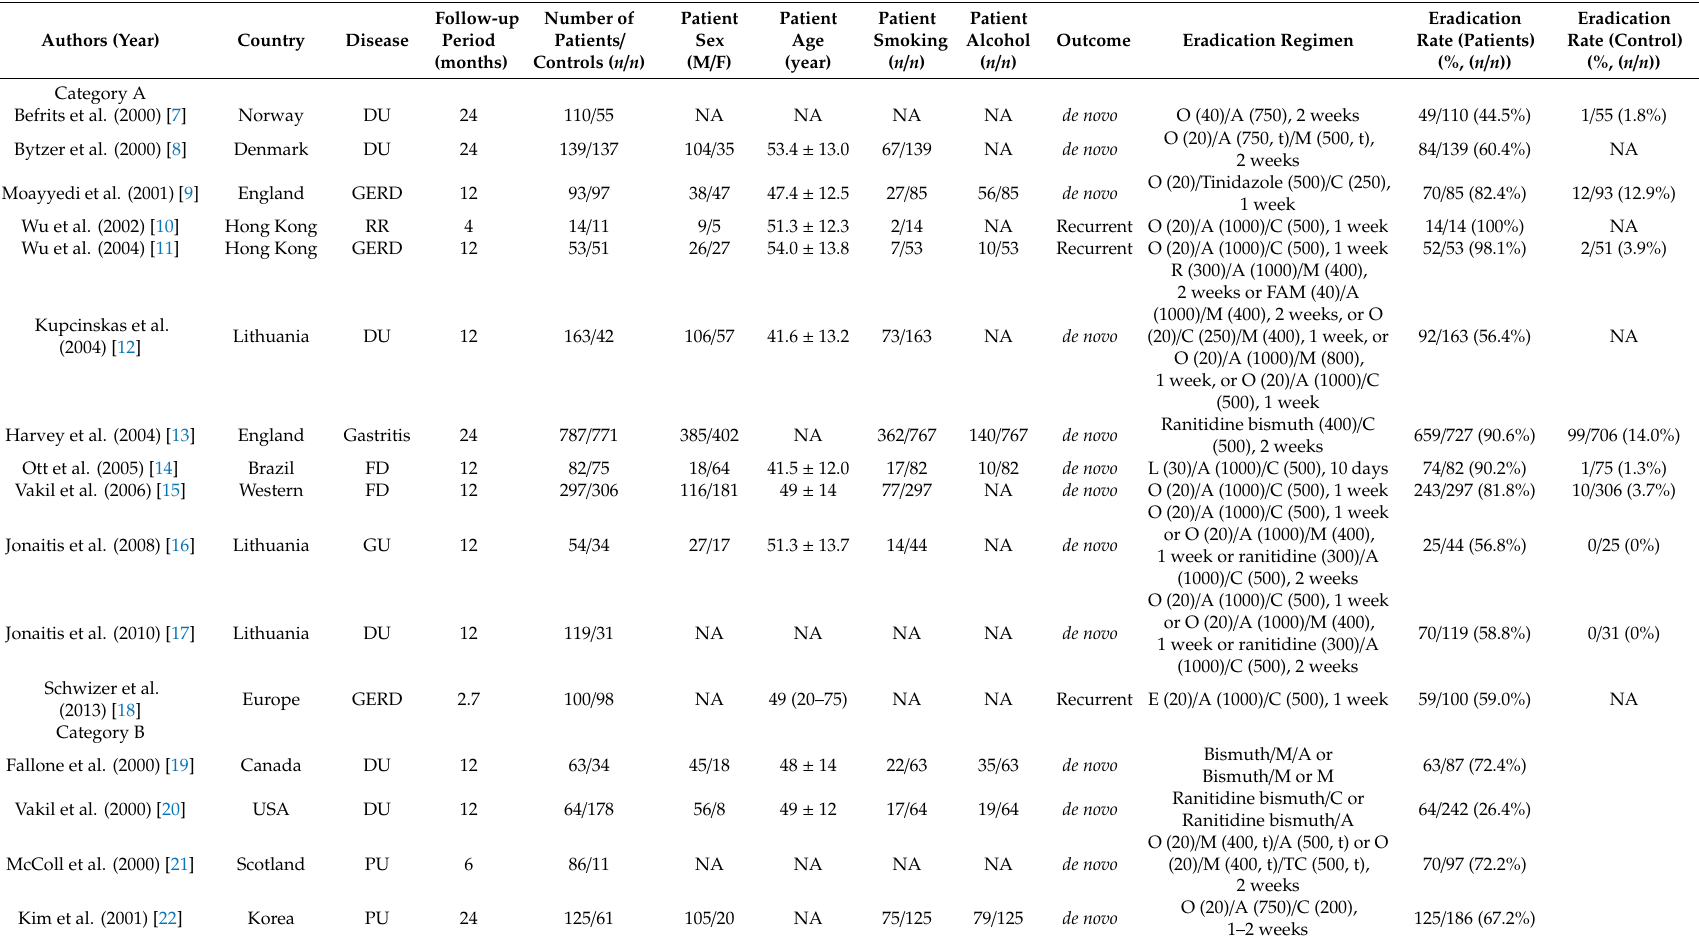
Table 1. Characteristics of the